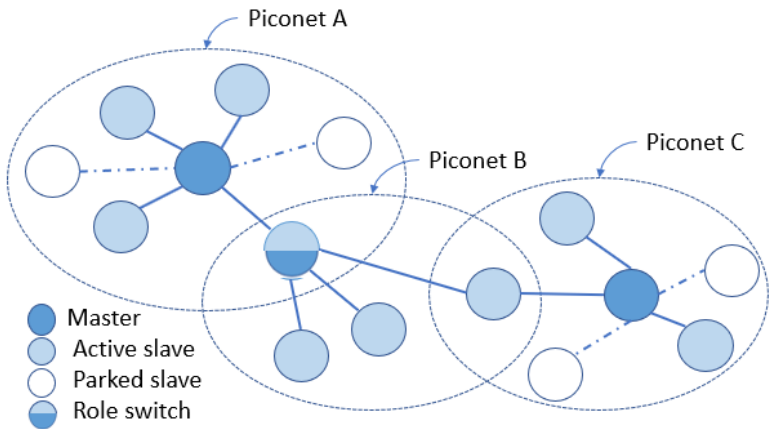
Figure 7. Different network topologies.